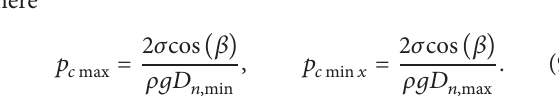
Figure 2: Comparison between the Brooks-Corey model and the new relations for different ranges of fracture apertures when 𝐷 𝑇 = 1 .